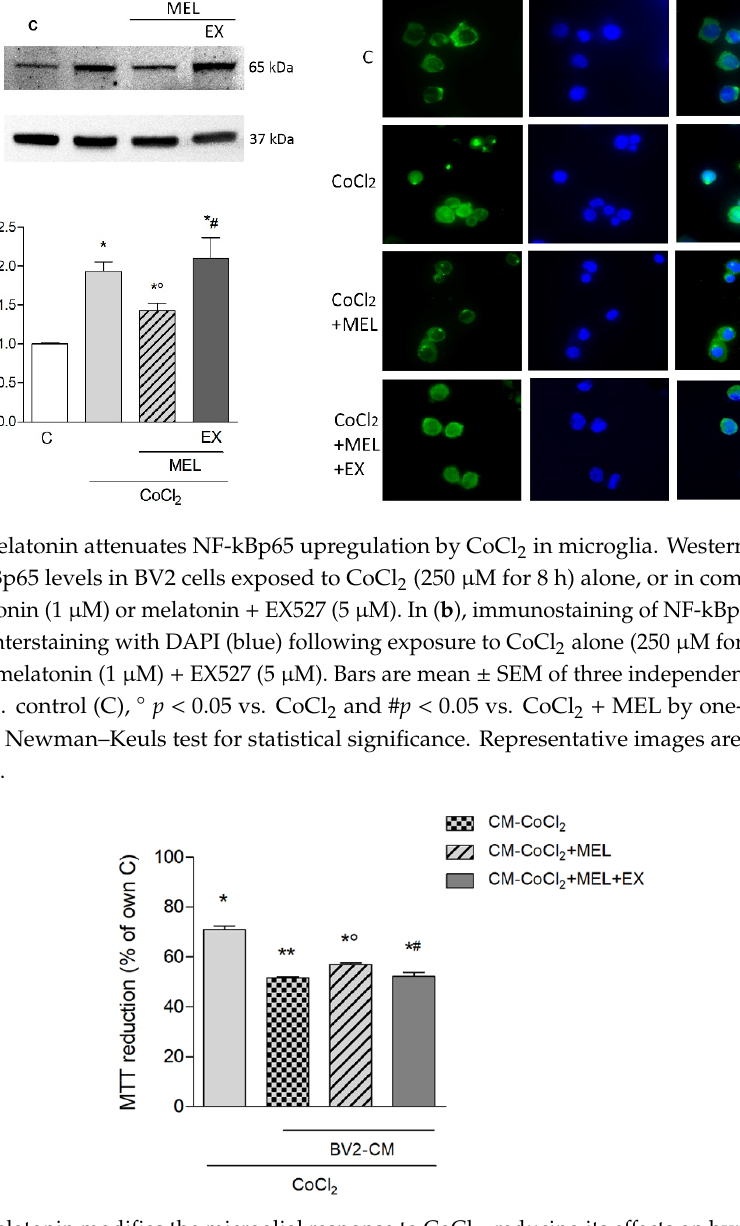
Figure 7. Melatonin modifies the microglial response to CoCl 2 , reducing its e ff ects on hypoxic neuronal damage. BV2 cells were pulsed with CoCl 2 (250 µ M) alone or in combination with melatonin (1 µ M) or melatonin + EX527 (5 µ M) for 3 h, followed by washing and recovery in fresh medium devoid of any drug. Conditioned medium (BV2-CM) was collected after further 18 h of incubation and transferred to SH-SY5Y during challenge with CoCl 2 (250 µ M for 24 h). Neuronal-like cell viability was then tested by the MTT assay. Bars are mean ± SEM of three independent experiments. * p < 0.05 vs. own control, ◦ p < 0.05 vs. CoCl + MEL + EX527. Another group by one-way ANOVA followed by Newman–Keuls 2 test for statistical